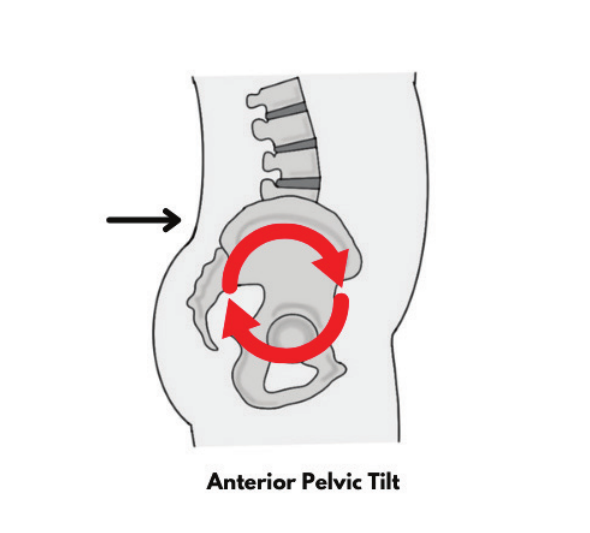
Figure-VII: Anterior pelvic tilt compensates both distal internal rotation and the requirement to minimize the hip flexion moment arm by shifting the COM closer to the hip axis.